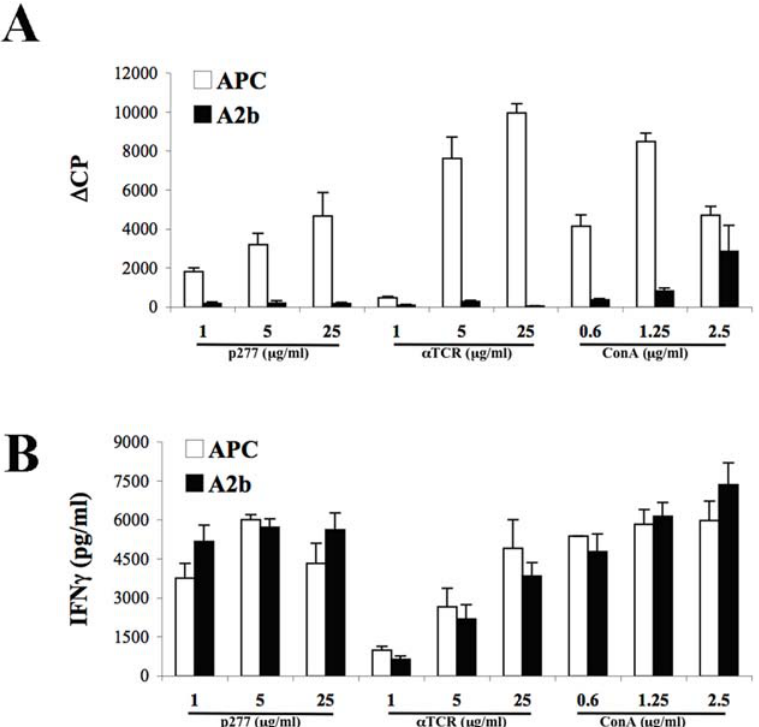
Figure 8. Anti-ergotypic HSP60-specific T cells become anergic after interacting with activated T cells. Anti-ergotypic Anti-p277 T cells were stimulated for 3 days with irradiated, activated A2b cells (A2b) or with irradiated APC fed with the p277 peptide (APC). The Anti-p277 T cells were maintained for 4 additional days in culture, and stimulated with APC and p277 peptide, Con A or immobilized anti-TCR ( a TCR) antibodies. T-cell proliferation (A) and IFN c (B) release were measured after 3 days. The proliferative responses are presented as the D CPM ( 6 SEM) (A), and the IFN c as pg/ml 6 SEM (B) of triplicate cultures. Three to five independent experiments produced similar results.